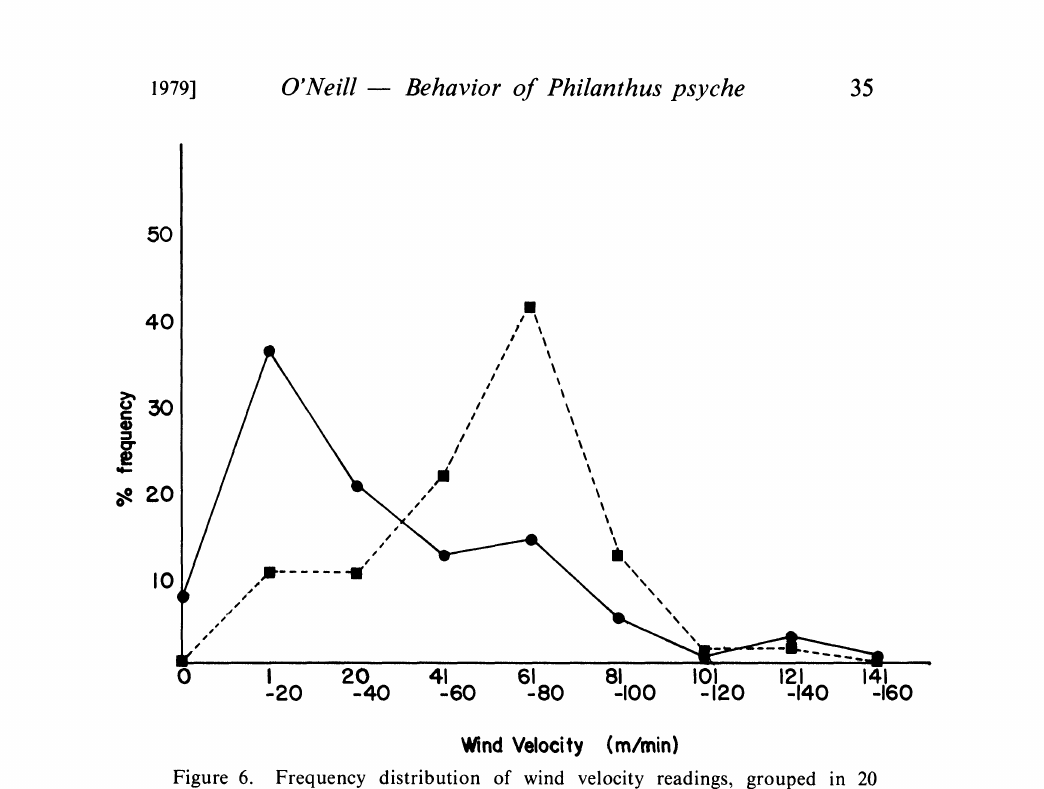
Figure 6. Frequency distribution of wind velocity readings, grouped in 20 m/min, intervals. The solid line indicates distribution of readings taken to measure mean wind velocity (N 287). The dashed line indicates frequency distribution of readings taken at initiation of abdomen dragging. different